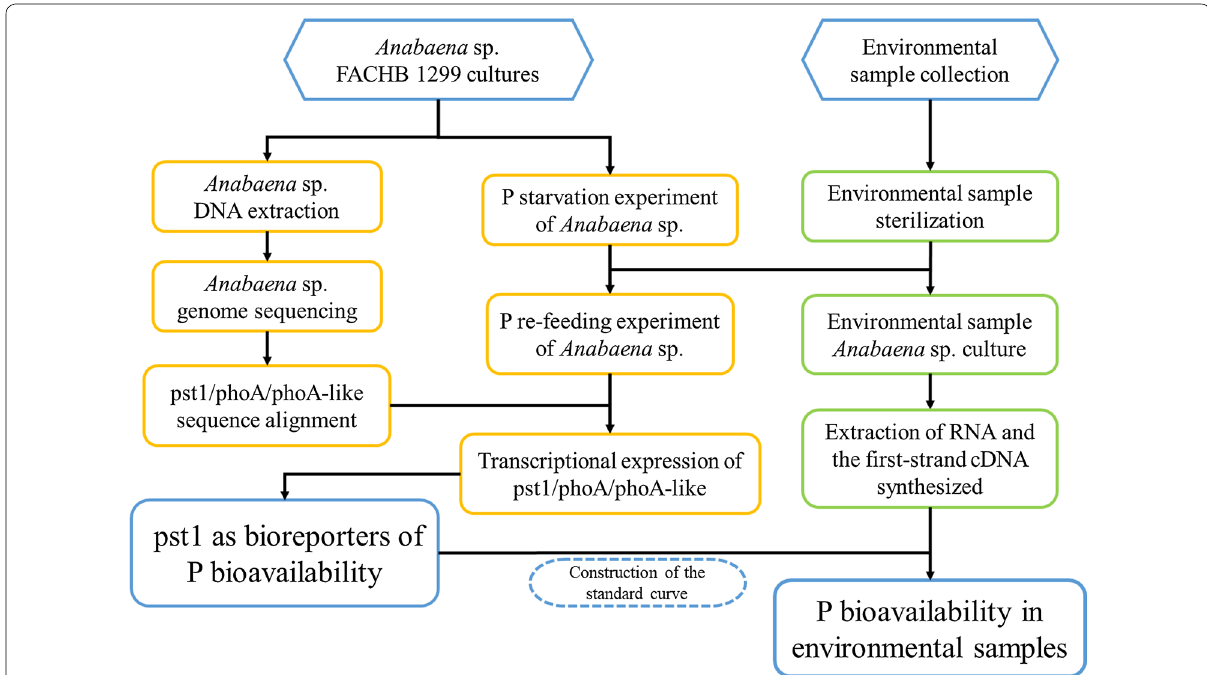
Fig. 1 Technology